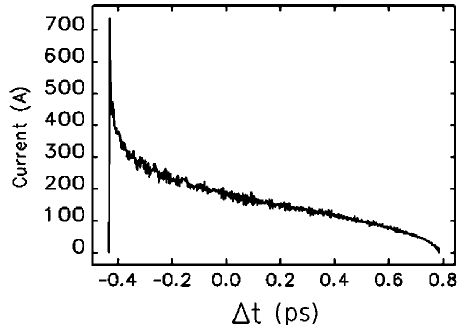
FIG. 4. Current profile after compression in BC1. C ¼ 6 : 5 is achieved with BC1 at 85 mrad bending angle, L1 rf phase at 25 (cid:3) far from crest. ELEGANT simulation result including CSR and